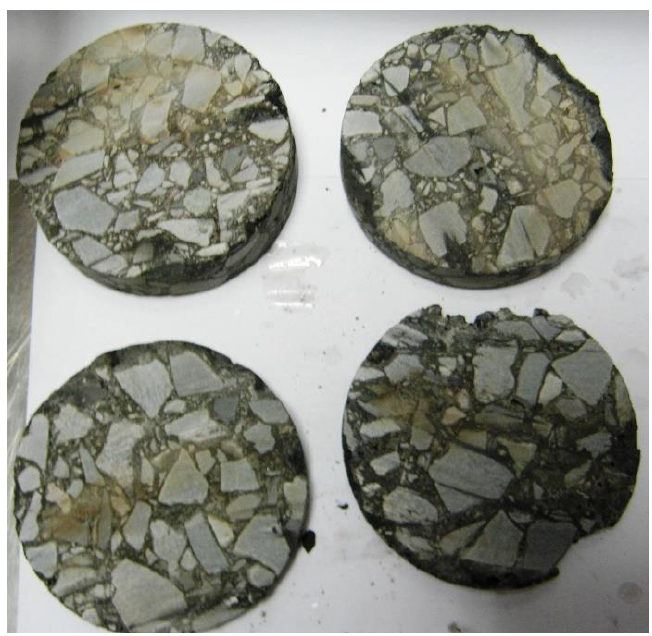
Figure 6. Sample taken from the 4 cm thick binder course, sliced into 0.8–1.0 cm slices.